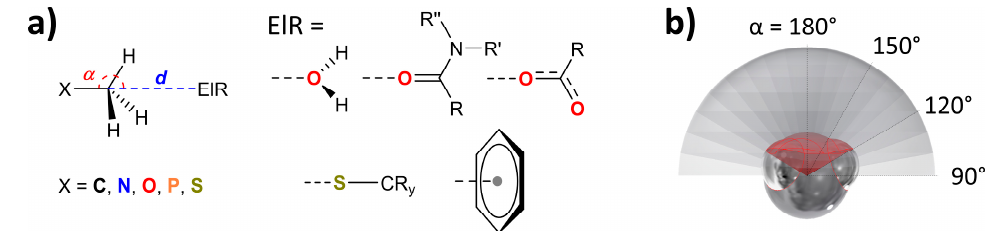
Figure 1. Representation of the method used to retrieve and analyse data from the CSD and the PDB. ( a ) general query to obtain data with d ≤ 5Å, α = 90°–180°, X = C, N, O, P or S and ElR (electron rich entity) is as indicated. ( b ) Illustration of the method used to assess directionality (see text for details).